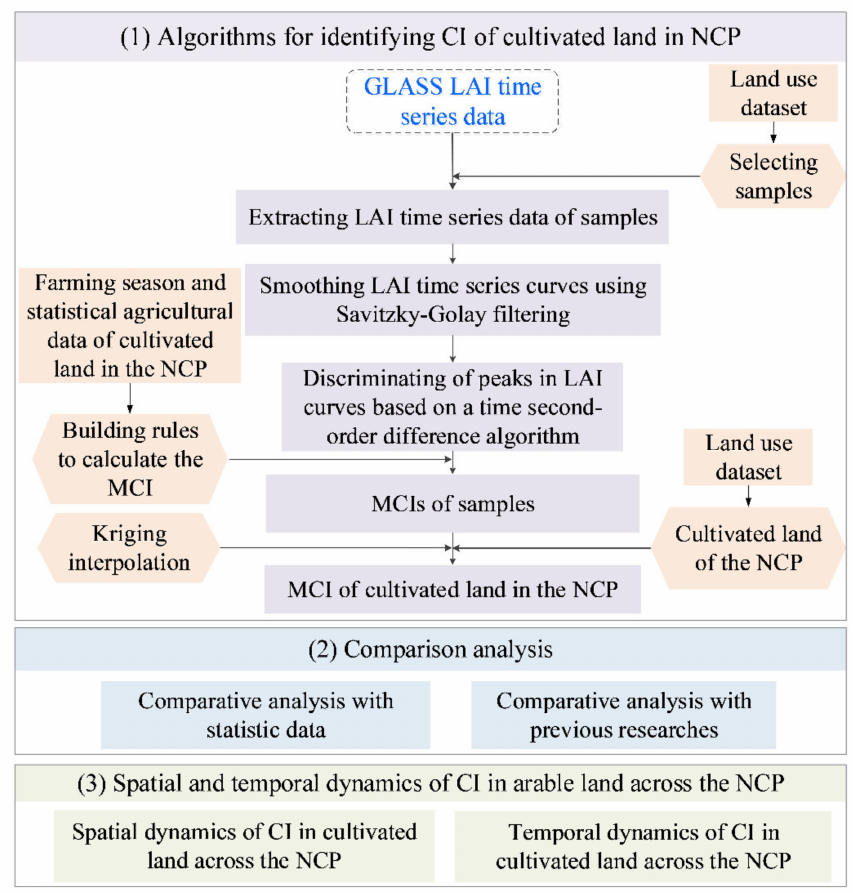
Figure 2. Diagram showing the processes used to determine the CI of cultivated